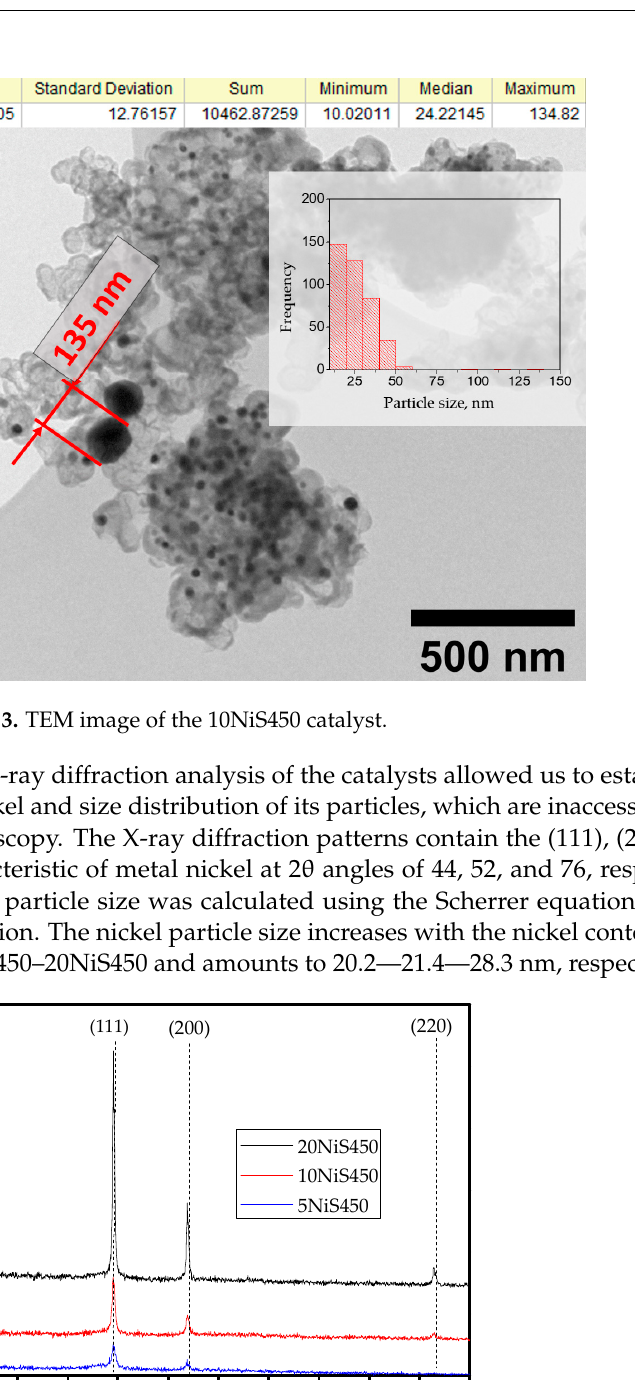
Figure 4. X-ray diffraction patterns of the nickel catalysts based on the Sibunit carbon material with nickel contents of 5, 10, and 20%.